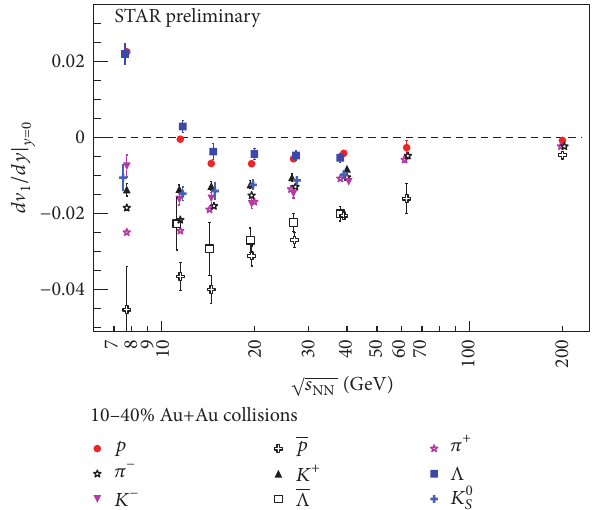
Figure 11: Beam energy dependence of V 1 (𝑦) slope for 𝑝 , Λ , 𝑝 , Λ , 𝜋 ± in 10–40% centrality Au+Au collisions [47, 90]. 𝐾 ± , 𝐾 0 𝑆 , and